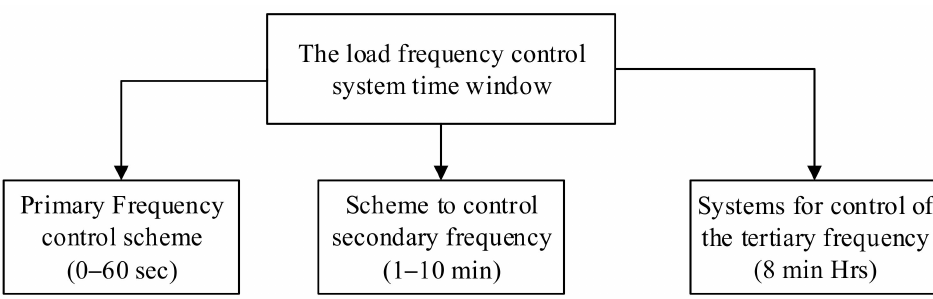
Figure 1. LFM Control scheme specified time